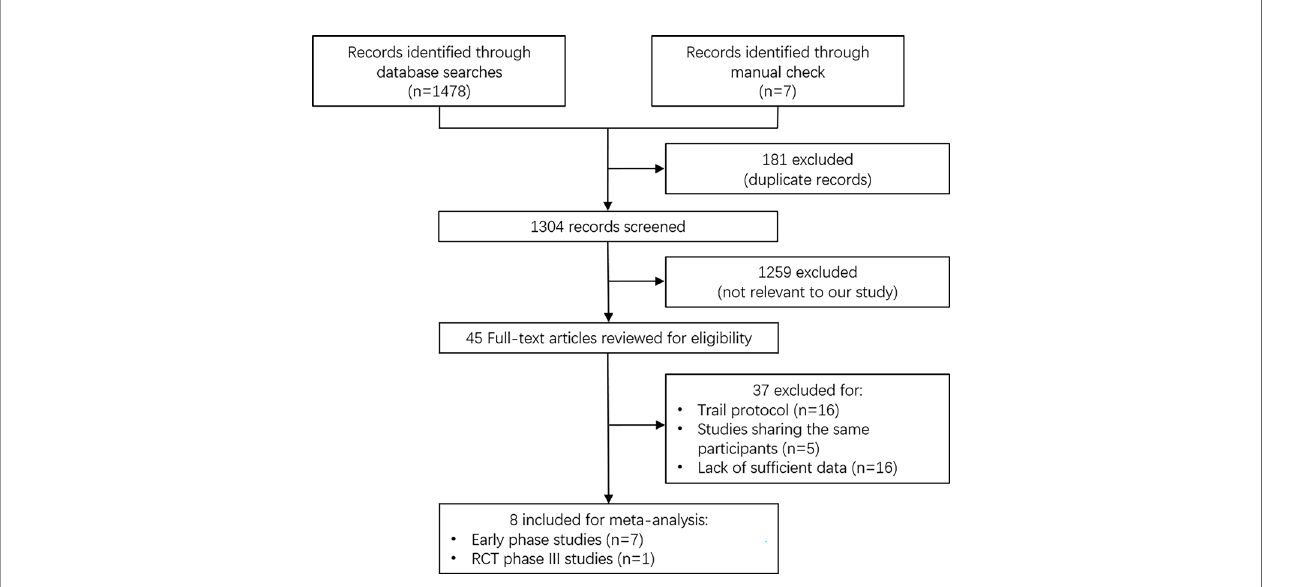
FIGURE 1 | Flow diagram for study